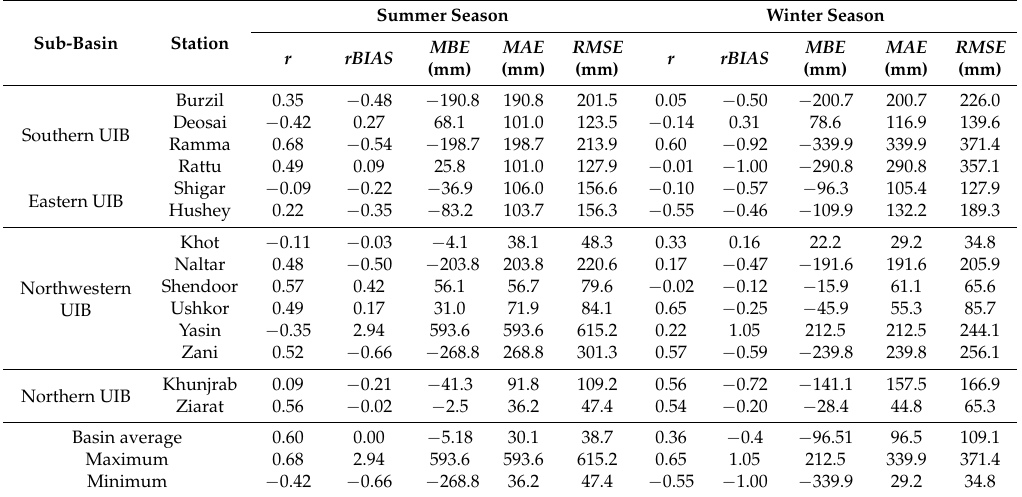
Table 5. Statistical analysis for summer and winter season data